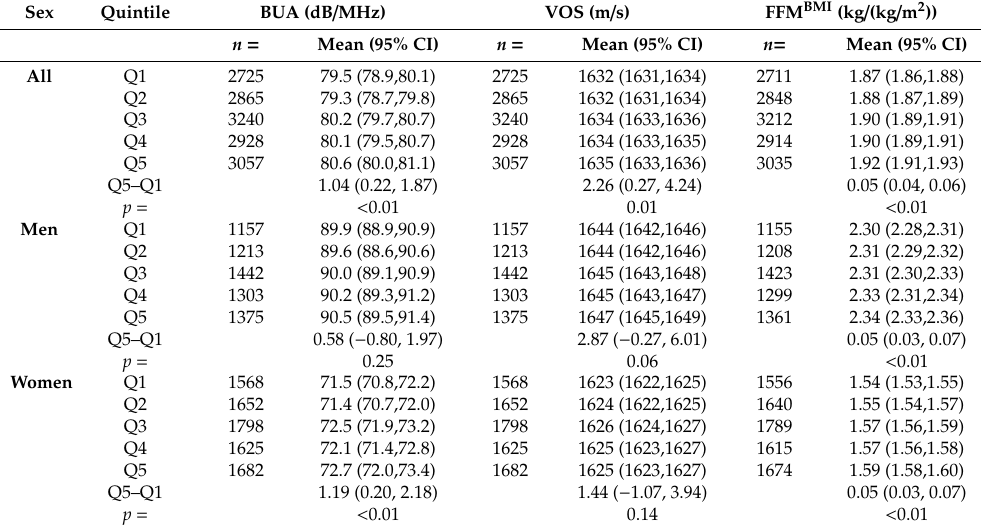
Table 3. Measures of broadband ultrasound attenuation, velocity of sound and fat free mass by quintile of alternative Mediterranean Diet Score in 14,815 men and women aged 42–82 years, stratified by sex 1 .